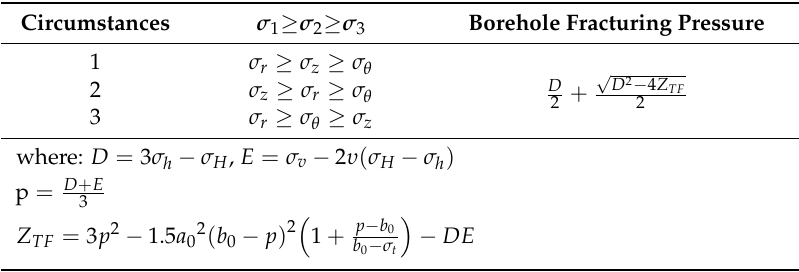
Table 3. Teardrop criterion for the determination of the fracturing pressure in an ice borehole.